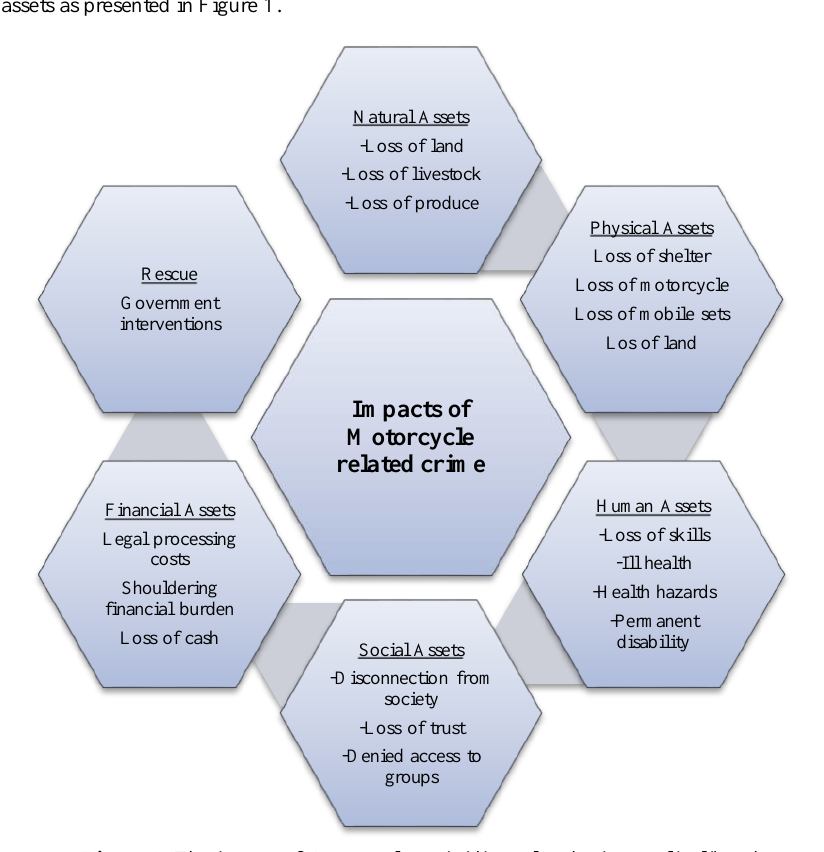
Figure 1: The impact of Motorcycle taxi riding related crime on